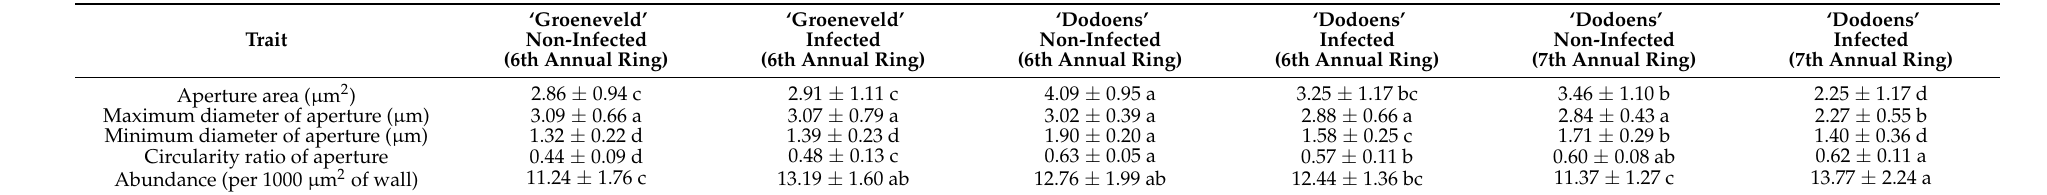
Table 2. Bordered pit anatomy of earlywood vessels in the examined Dutch elm hybrids.